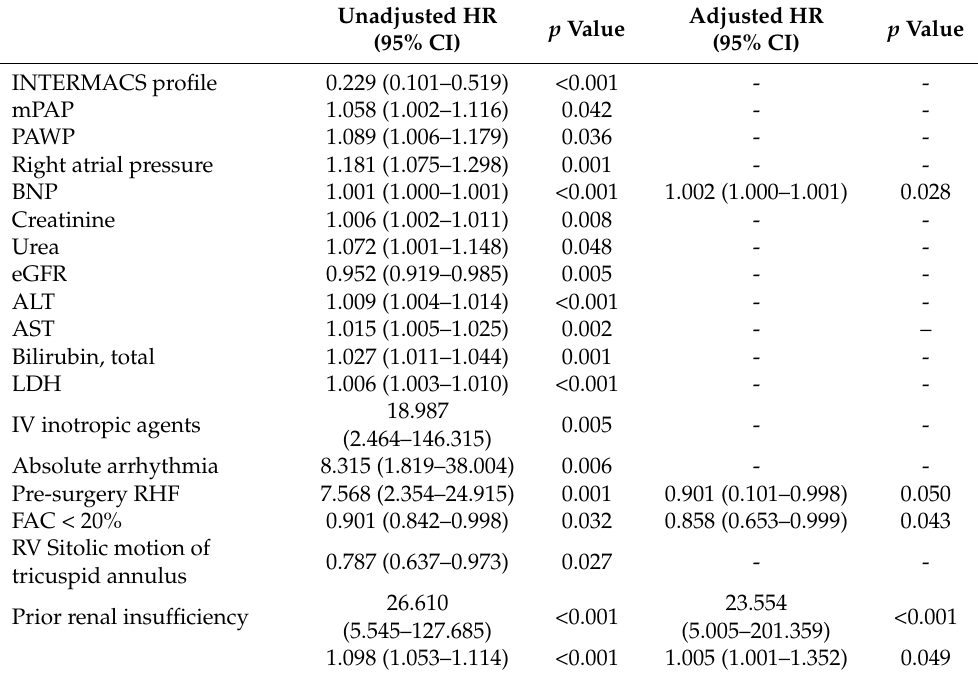
Table 3. Predictors of early RHF development.